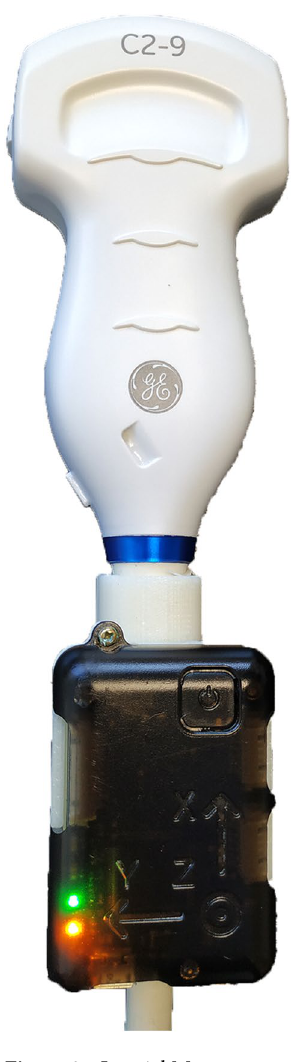
Figure 2. Inertial Measurement Unit (IMU) device attached to a curvilinear ultrasound transducer, acting as the sonographer hand tracking device. Figure created using Microsoft Office version 365 (https:// office. micro soft.